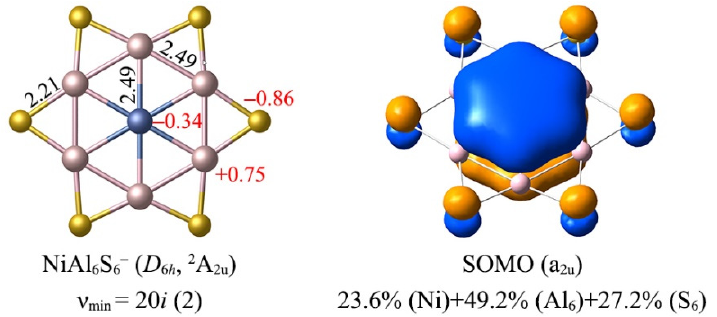
Figure 5. Optimized structures D 6 h NiAl 6 S 6 − at the PBE0/def2-TZVP level. The bond distances (in Å; black color), atomic nature charges ((in |e|; red color), the lowest vibrational frequency ν min (cm − 1 ) and the number of imaginary frequencies are shown. The SOMO and its compositions are also listed.